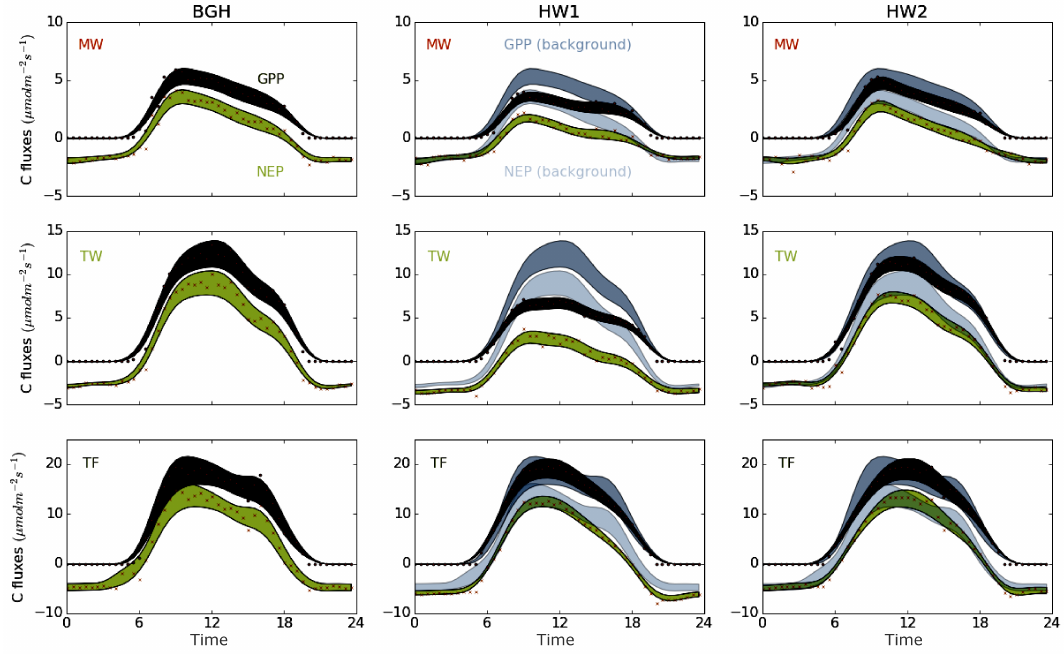
Figure 7. Diurnal course of net ecosystem productivity (NEP, light green) and gross primary productivity (GPP, dark green) at the Mediter- ranean woodlands (MW, top row), the temperate woodlands (TW, middle row) and the temperate forest (TF, lowest row) for the background period (BHG), and the first and second period of the heat wave (HW1, HW2). Filled areas indicate the range of smoothed ± 1 standard deviation values, average mean values are indicated by red symbols. Background GPP values (dark grey) and NEP values (light grey) are also plotted in HW1 and HW2 to allow for easier